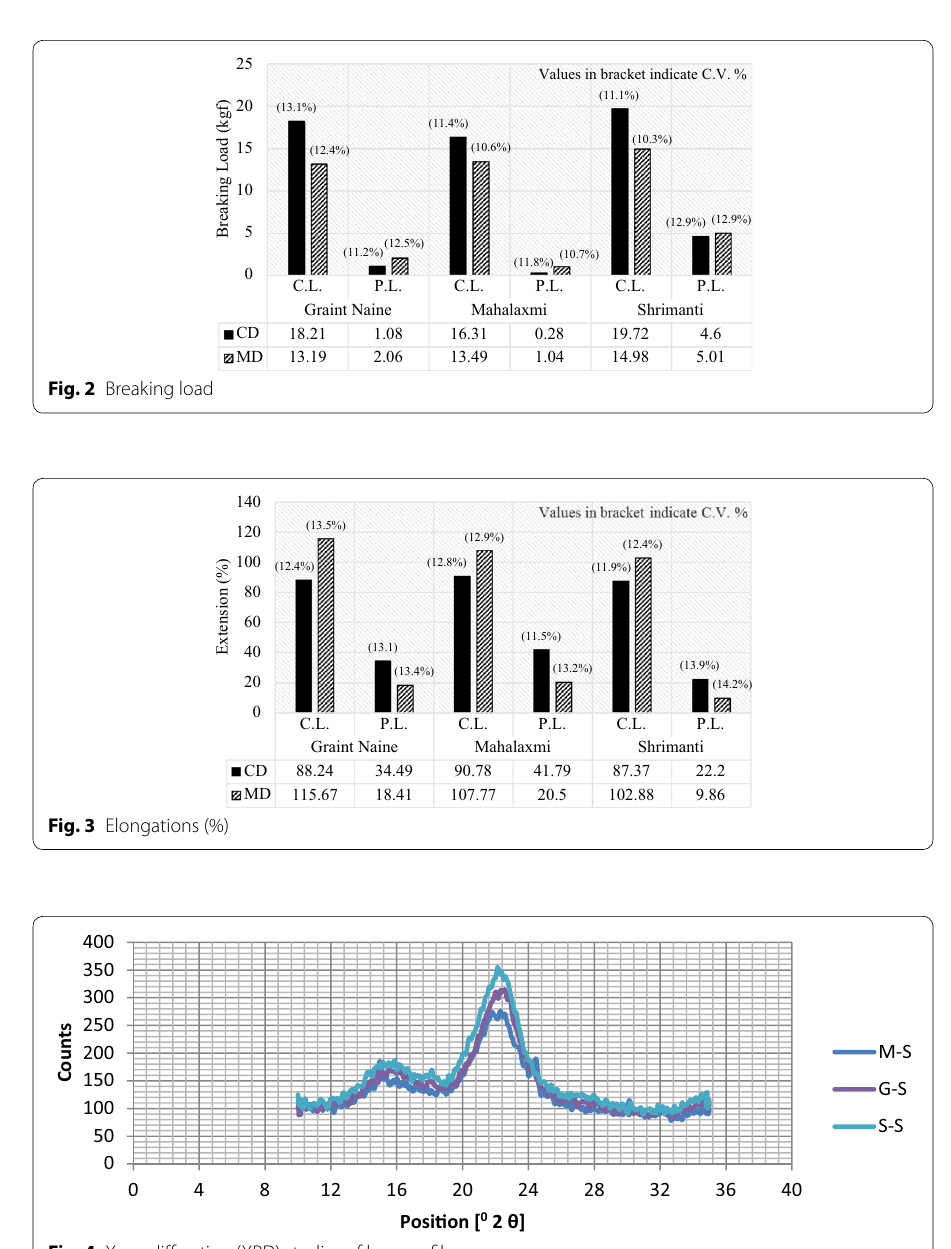
Fig. 4 X-ray diffraction (XRD) studies of banana